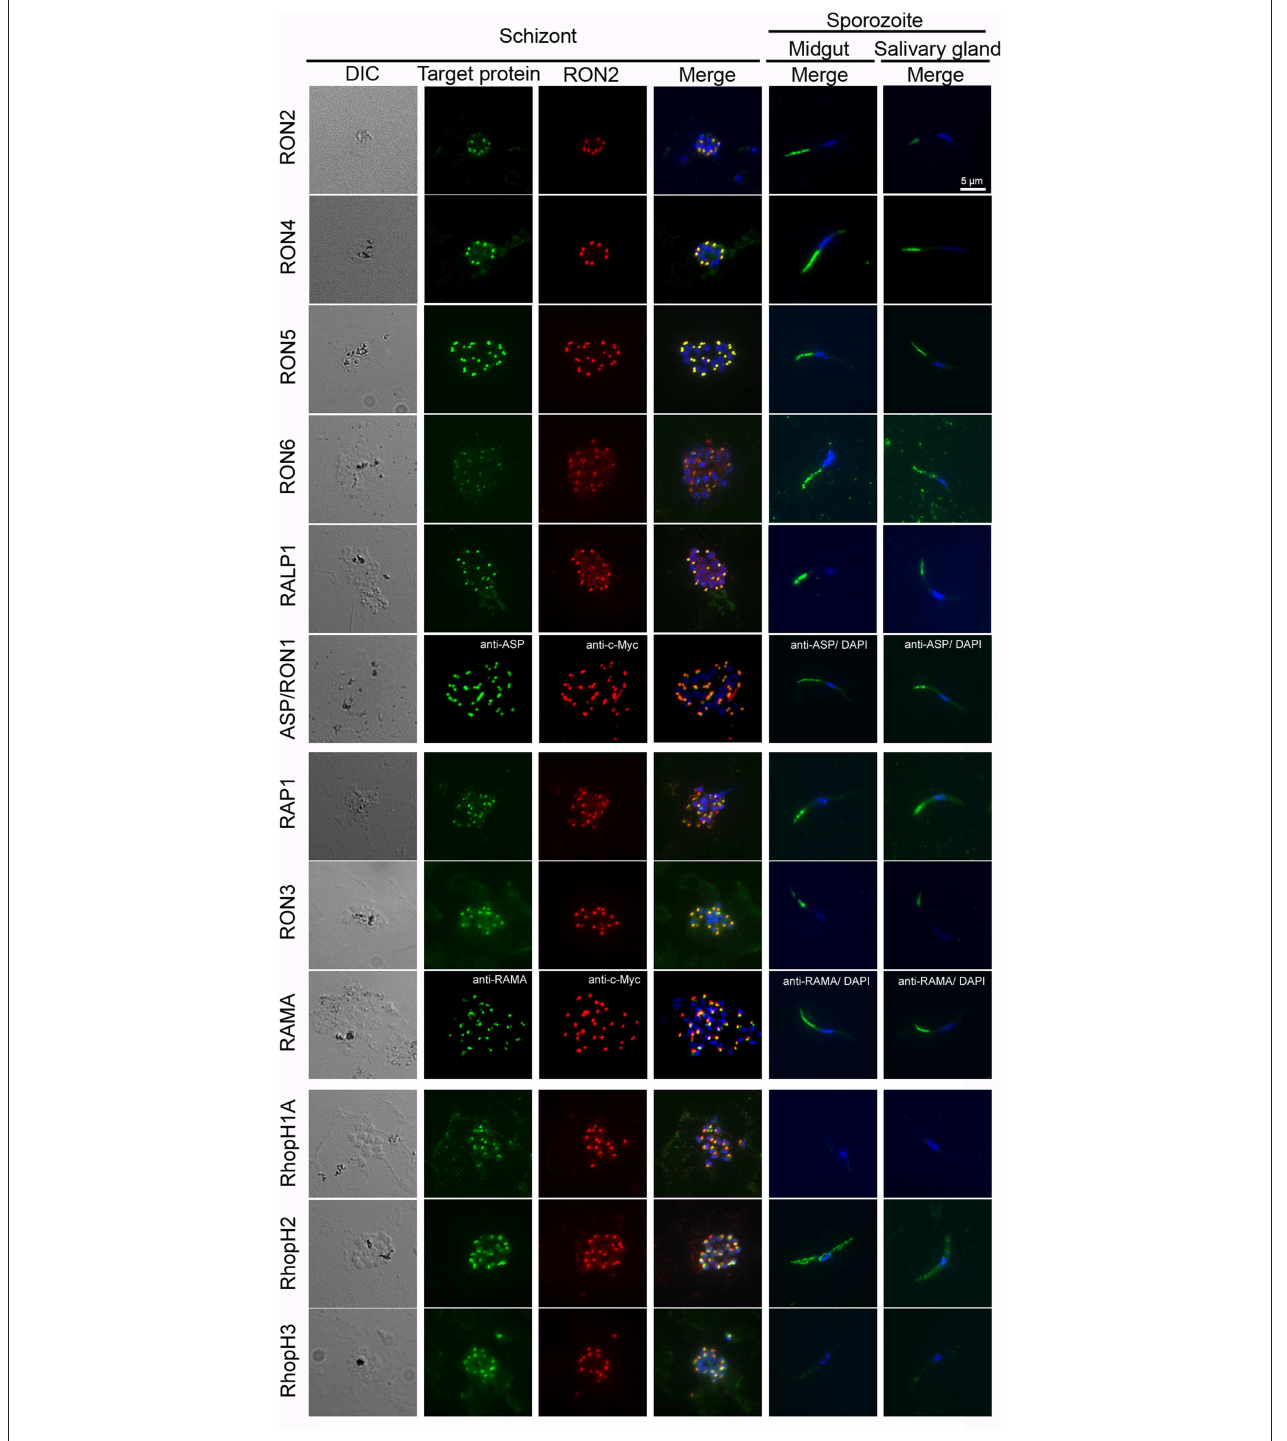
FIGURE 3 | Expression pattern of rhoptry proteins in merozoites and sporozoites. Schizonts and sporozoites collected from midguts or salivary glands at day 24–26 post-feeding were fixed with acetone on glass slides. In schizonts, anti-c-Myc antibodies were used to detect target c-Myc fused rhoptry protein (shown in green) in each transgenic parasite, which is compared with the localization pattern of RON2 (shown in red) and nuclei (blue) stained by anti-RON2 antibodies and DAPI, respectively. To detect ASP/RON1 and RAMA, RON2-c-Myc transgenic parasites were used as antigens and target proteins and RON2 was detected by specific antibodies (green) and anti-c-Myc antibodies (red). Differential interference contrast (DIC) images are shown in the left panels. In sporozoites (right two panels), the localization of target proteins (green) and nuclei (blue) are shown in the merged images. Bar indicates 5 µ m.